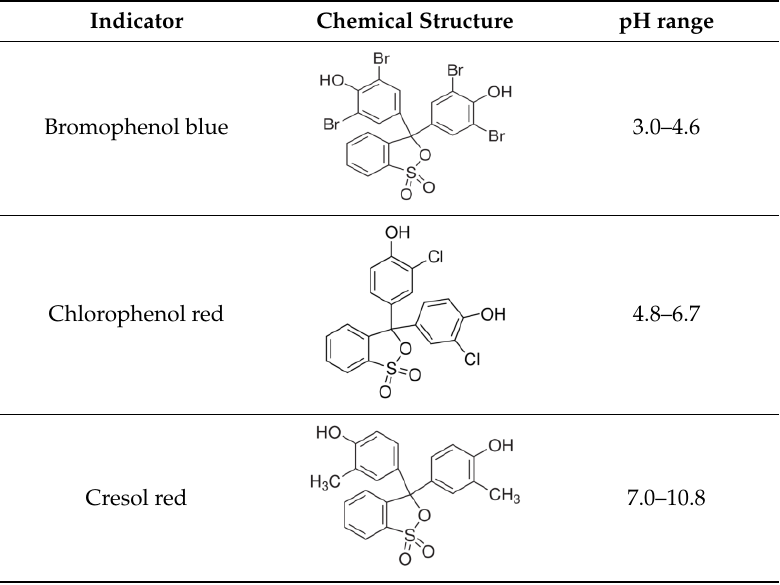
Table 2. pH indicators used for the development of the sol-gel derived pH sensitive overlayer.